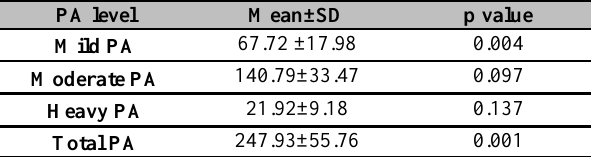
Table 2: Physical activity (PA) levels of participants according to